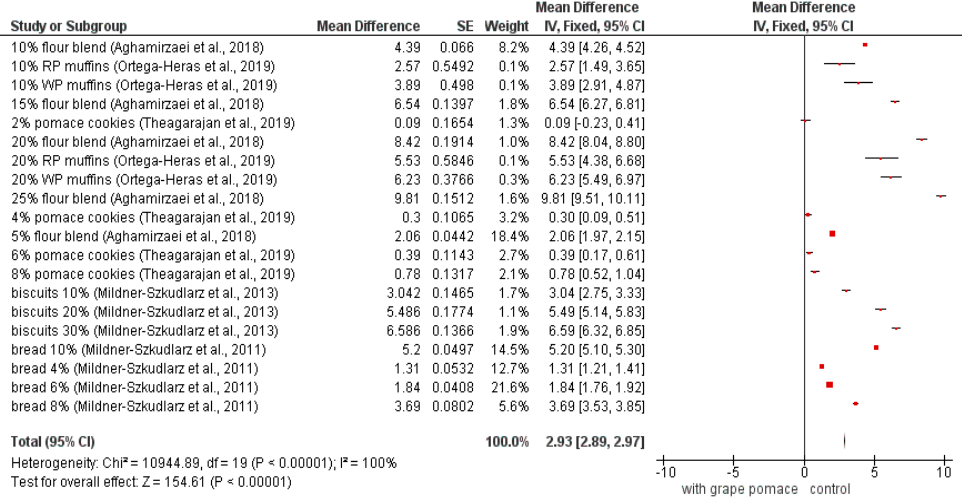
Figure1. Meta-analysisofTDFinfortifiedproducts[20,23,43,45,75]; RP—redgrapepomace; WP—white Figure 1. Meta-analysis of TDF in fortified products [20,23,43,45,75]; RP—red grape pomace; WP— grape pomace; SE: standard white grape pomace; SE: standard error.